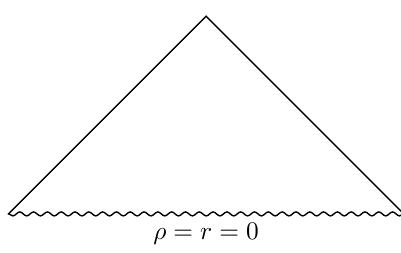
Figure 4 . Projection diagram of the warped (cid:13)at quotient in the case where (cid:24) + ! = 0. Due to the occurence of closed timelike curves the spacetime is cut o(cid:11) at (cid:26) = r = 0, resulting in a singularity (wiggled